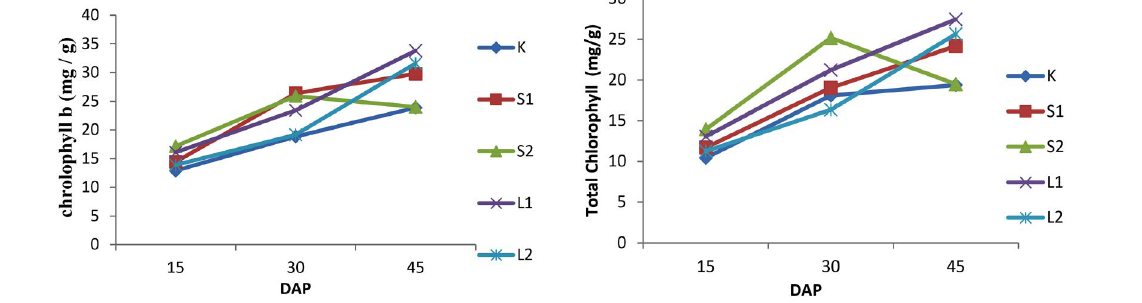
Fig. 6. Induced compost effect on total chlorophyll content. K = control; S1 = Cellulolytic (10%); S2=Cellulolytic (20%); L1 = Ligninolytic (10%); L2 = Ligninolytic